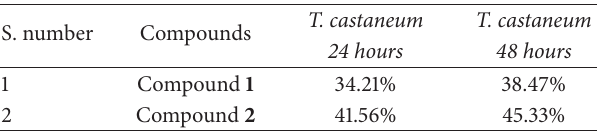
Figure 2: 5,7,4 󸀠 -Trihydroxy-6,8-dimethoxyflavone. Table 5: Percentage mortality rate of T. castaneum against com- pounds 1 and 2